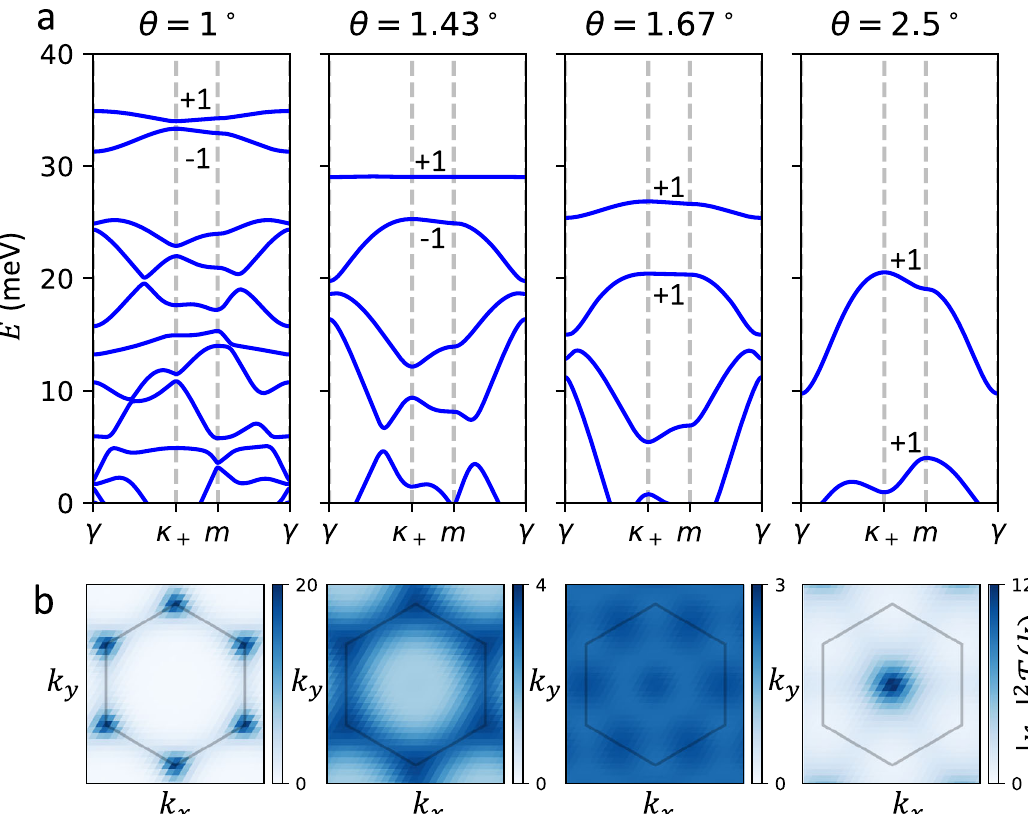
Fig. 2 Continuum model band structure and Berry curvature at various twist angles. a The band structure E i ( k ) along with the Chern numbers of the fi rst two bands and ( b ) the (scaled) Berry curvature j κ þ j 2 F ð k Þ of the fi rst band is shown for the continuum model at θ = 1 ∘ , 1.43 ∘ , 1.67 ∘ , and 2.5 ∘ . At θ = 2.5 ∘ , the fi rst band maxima is located at the κ γ . At θ = 1 ∘ , the band maximum is instead at γ and F is peaked at κ ± points and the Berry curvature is peaked at ± . During the crossover region between these angles, E 1 ( k ) and F ð k Þ both become very fl at. We fi nd that the band dispersion E 1 ( k ) is fl attest at θ ≈ 1.43 ∘ and the Berry curvature F ð k Þ is most uniform at θ ≈ 1.67 ∘ , both shown.